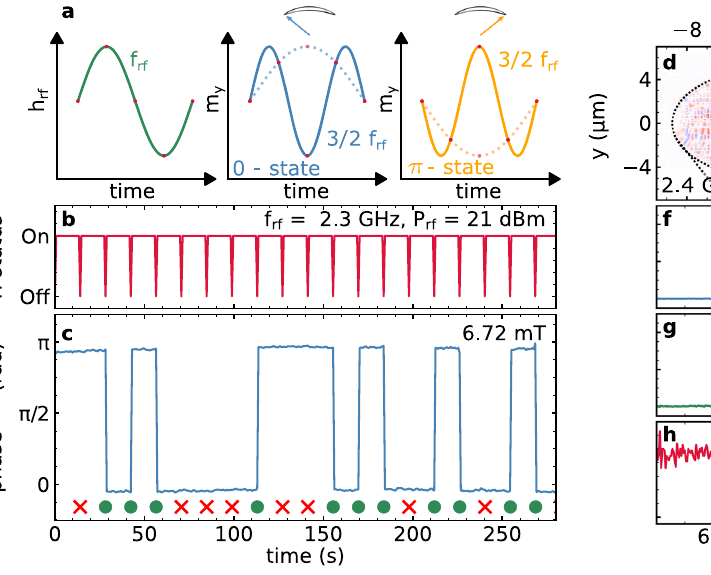
Fig. 3 | Phase stability of NLSWs. a The rf-driving fi eld at f rf (green) results in parametrically generated magnons at half-integer multiples of the driving fre- quencywithtwodistinctphasestates.Thesolid linesdepictthe 0-stateinblueand the π -state in yellow for the 3/2 f rf non-linearity while the dotted line show the corresponding states for 1/2 f rf . b The rf-power modulation as a function of time while the phase of the NLSW response is depicted in c . The phase of the NLSW signal randomly jumps to the π -state or stays in the 0-state after switching the rf-